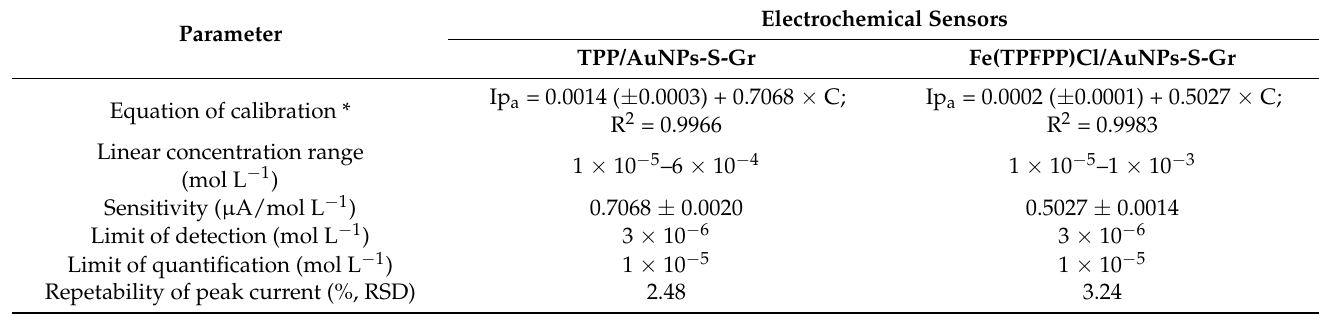
Figure 5. ( a ) Differential pulse voltammograms of 1 × 10 − 4 mol L − 1 R-limonene using the Fe(TPFPP)Cl/AuNPs-S-Gr sensor in PBS at pH values of 1.5, 1.8, 2.0, 3.0, 4.0, 5.0, and 6.0. ( b ) The effect of the pH on the peak current (black dots) and the linear dependence of the peak potential with the pH (blue line).